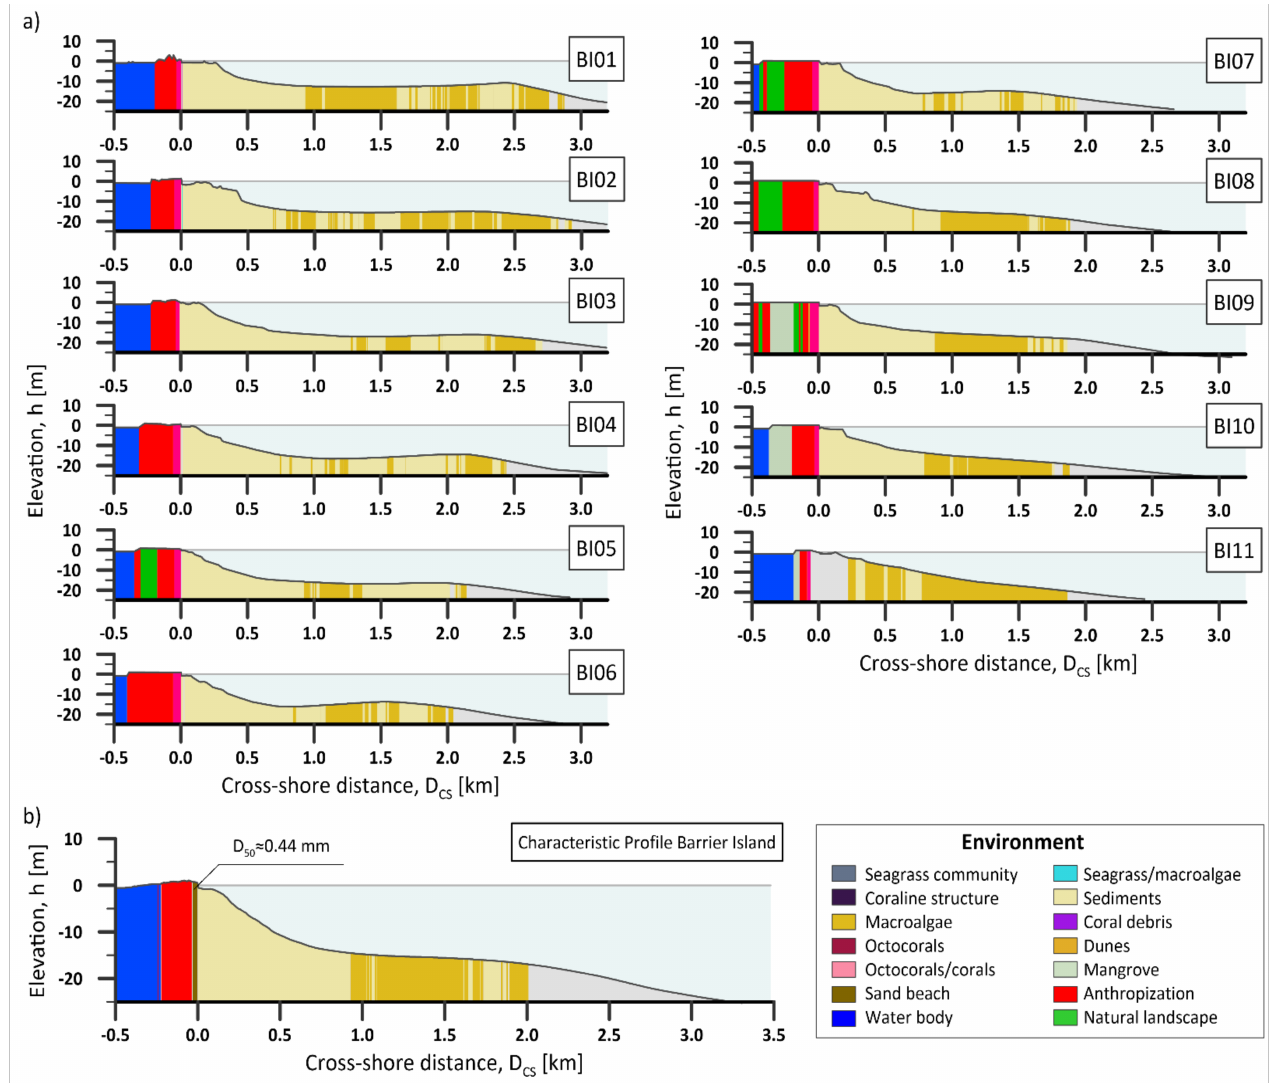
Figure 7. Beach profiles at the Cancun barrier island, extending from 500 m inland, towards a water depth of 20 m. The shoreline is located at a cross-shore distance D C S = 0 m. The profiles ( a ) are numbered from north to south as in Figure 1. The land use on the Cancun barrier island ( b ) corresponds to profiles BI01-BI11.